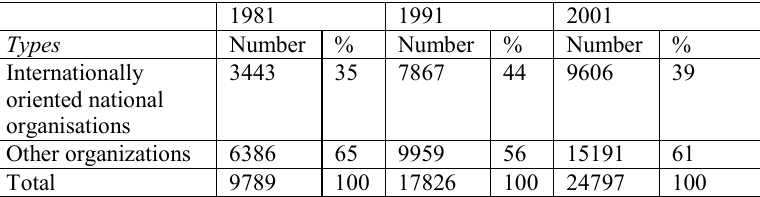
Table 1 . International NGOs by major form characteristics, 1981-2001. 1981 1991